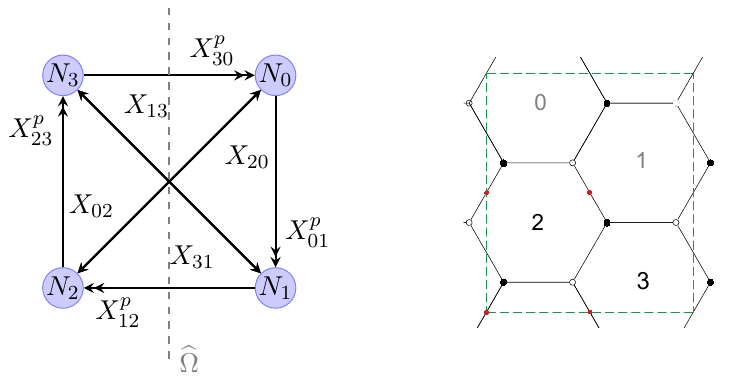
Figure 28. The quiver and the corresponding dimer for the orientifold involution ^(cid:10) of C 3 = Z 4 . Anomaly condition